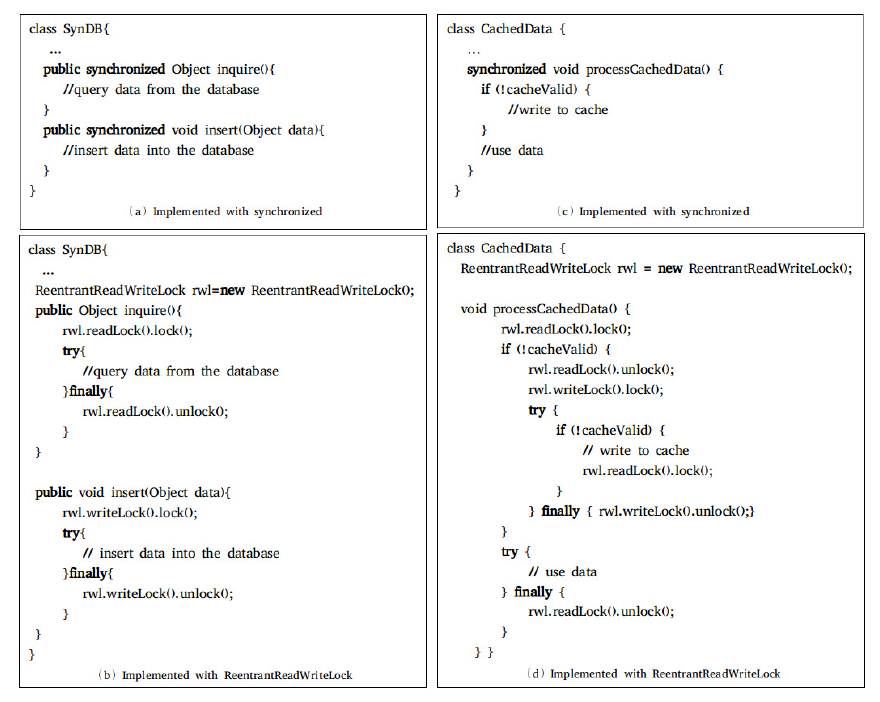
Figure 1. ( a ) The method implemented with synchronized locks; ( b ) the method implemented with ReentrantReadWriteLocks ; ( c ) the method implemented with synchronized locks; and ( d ) shows the method implemented with lock downgrading of ReentrantReadWriteLocks